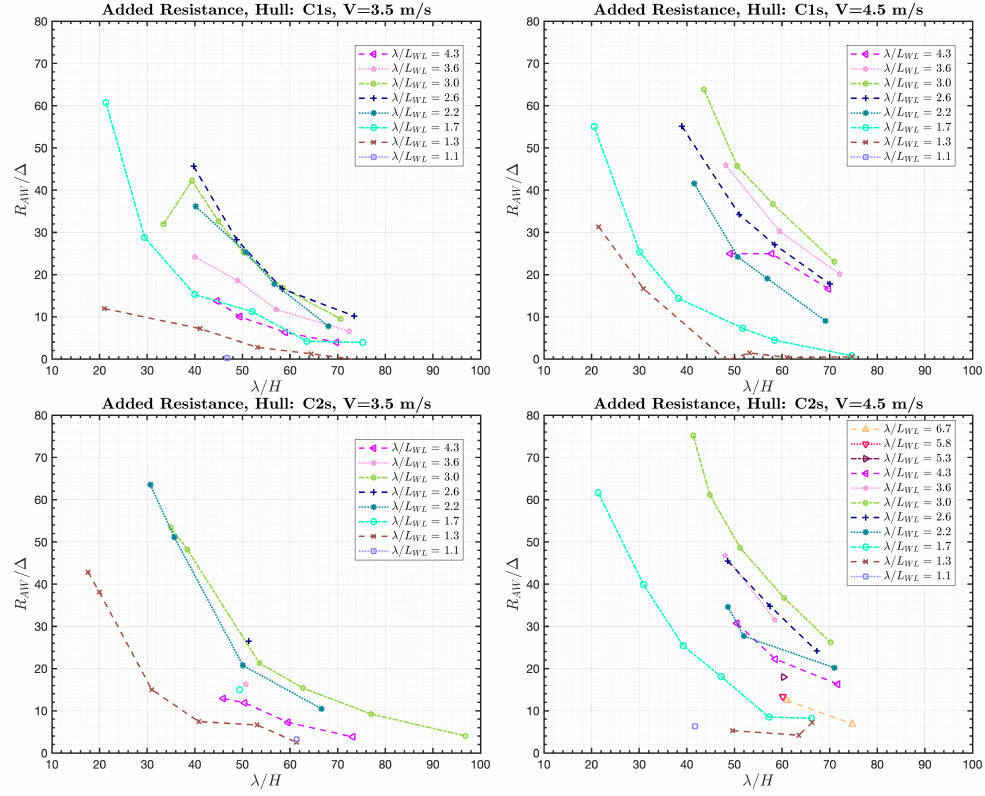
Figure 8. Added resistance vs. λ / H